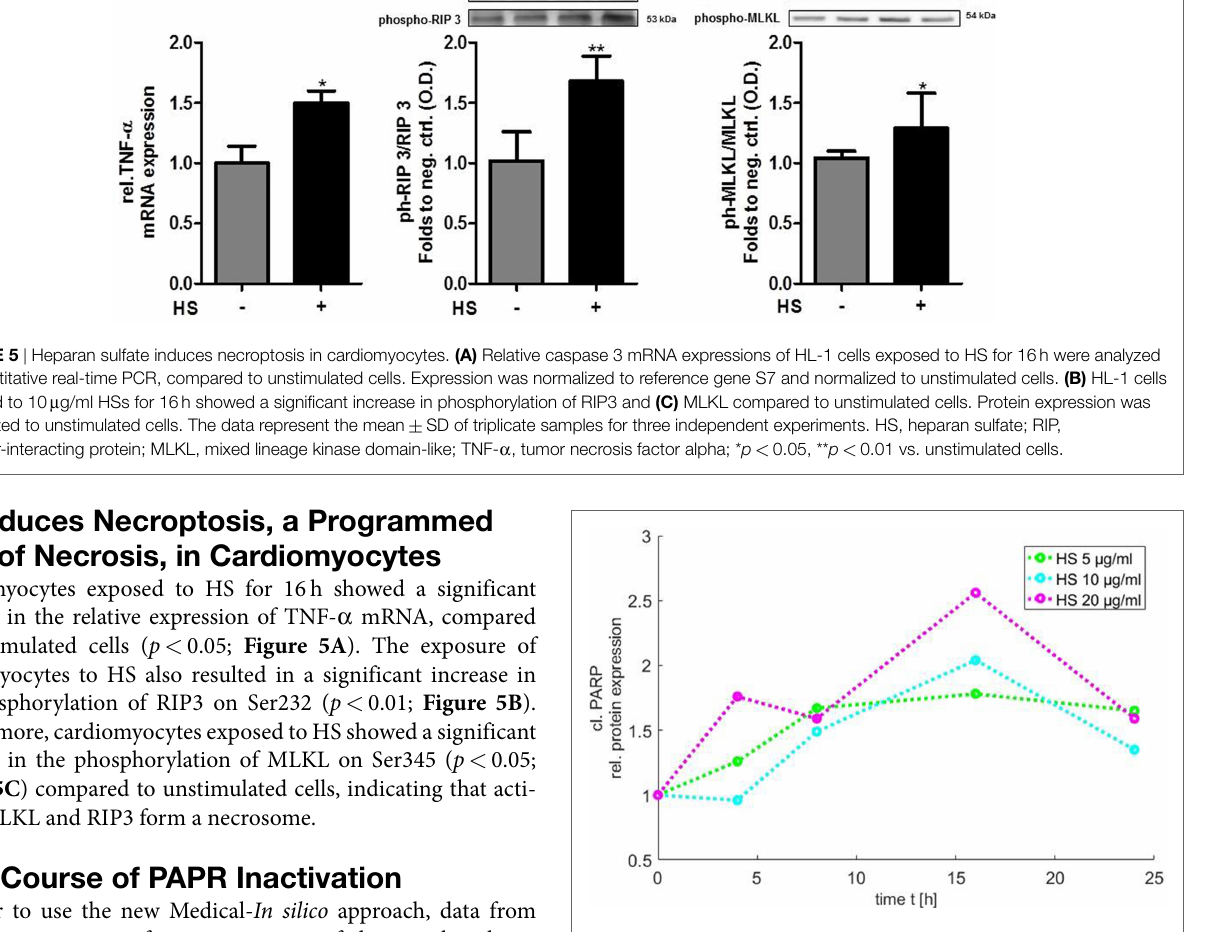
FIGURE 6 | Time course of PARP inactivation. The relative PARP inactivation was analyzed by using Western blot and detected after 4, 8, 16, and 24h after treatment of cardiomyocytes with 5, 10, or 20 μ g/ml HS, respectively. HS, heparan sulfate; PARP, poly-(ADP-ribose)